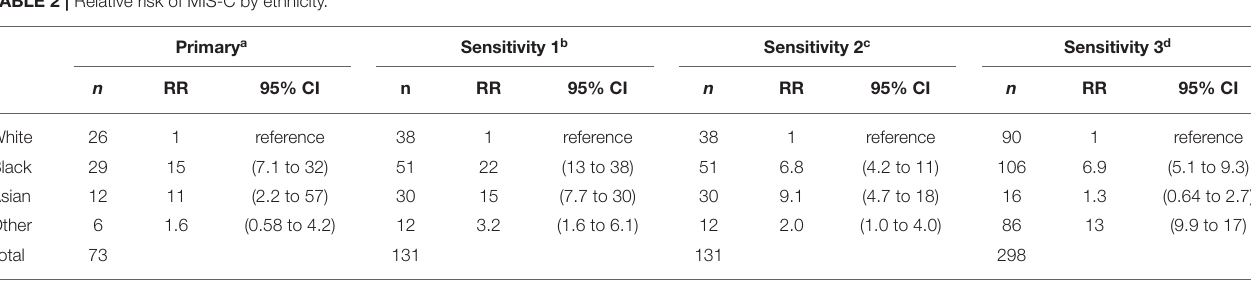
TABLE 2 | Relative risk of MIS-C by